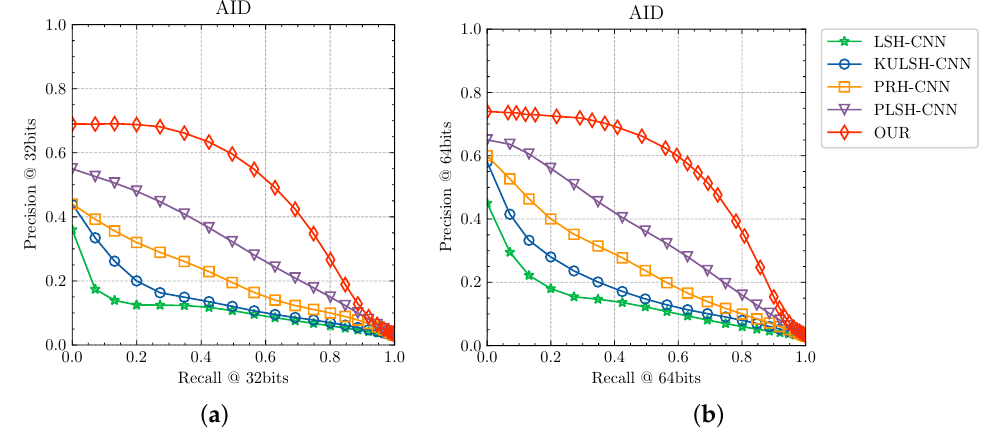
Figure 9. Precision-recall curves on the AID dataset. ( a ) Precision-recall curve@32 bits. ( b ) Precision- recall curv@64